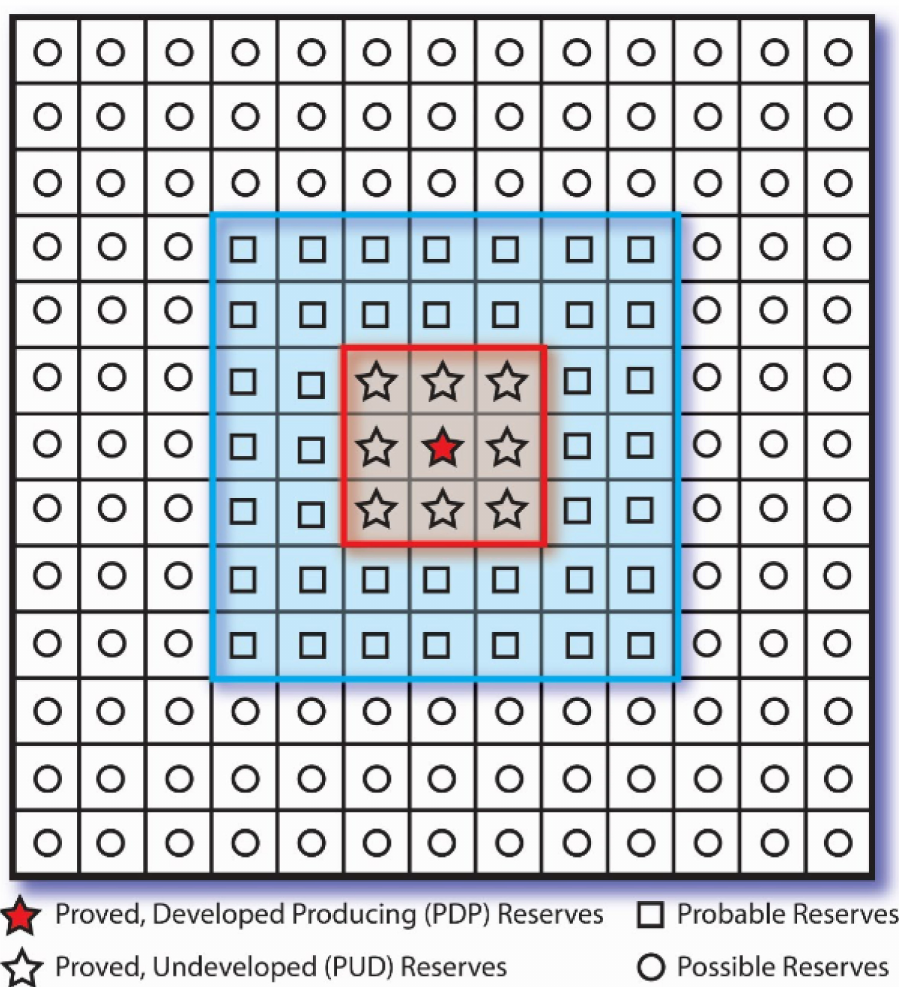
Figure 5. Schematic of possible arrangement of Proved, Probable, and Possible Reserves based on a well drainage unit, represented here by individual squares. The size of each drainage unit will be determined by permeability and well